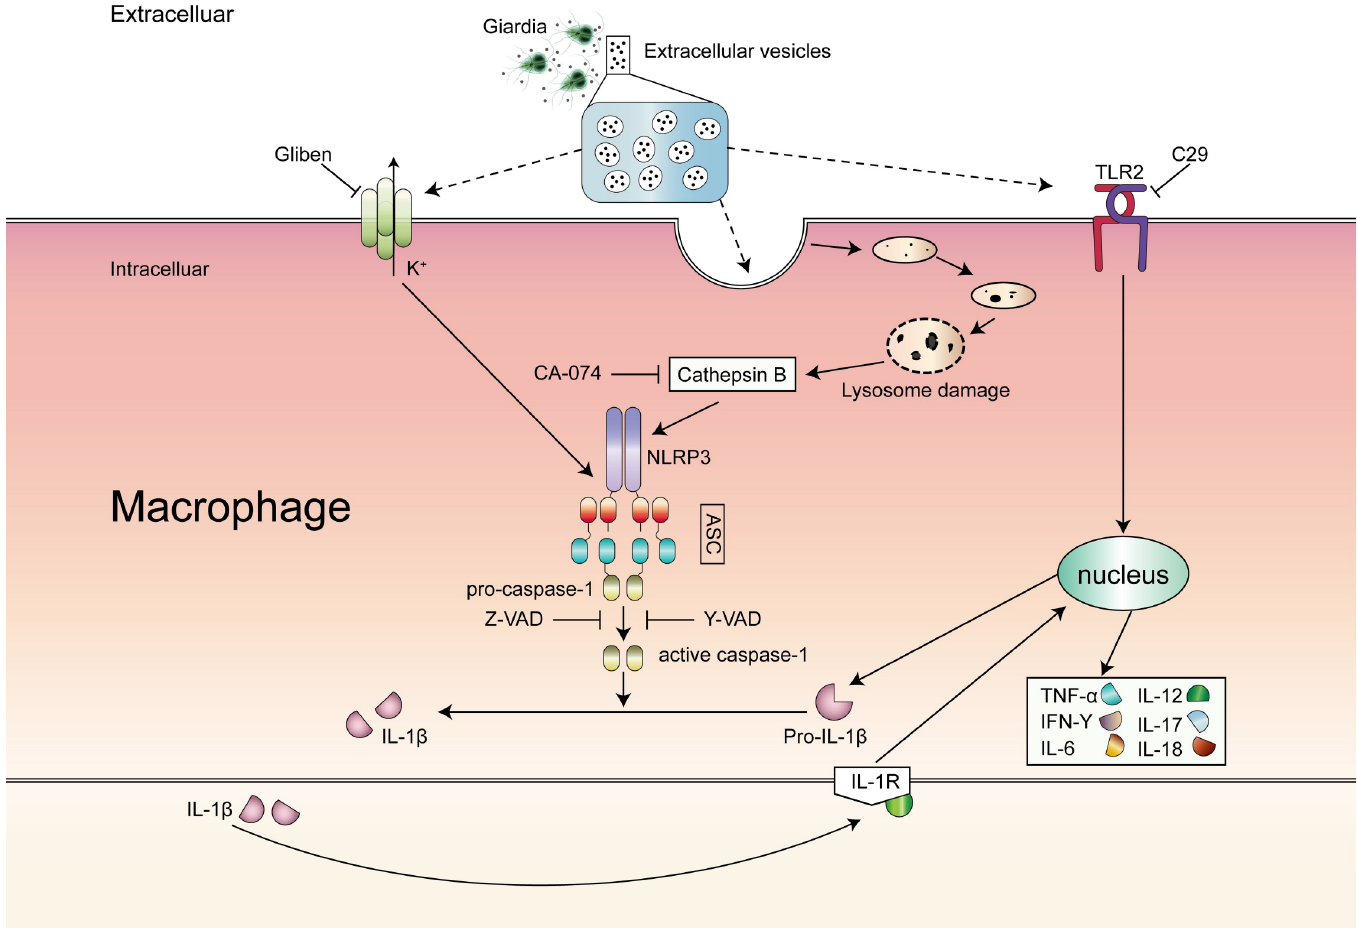
Fig 8. Schematic diagram of mechanisms underlying GEVs-induced inflammatory response. GEVs were secreted by G . duodenalis and entered into host cells triggering inflammatory response by recognizing extracellular TLR2 and intracellular NLRP3. NLRP3 inflammasome was activated, mediated IL-1 β release and controlled cytokines secretion. This process could be completely reversed by CA-074 methyl ester/zVAD-fmk or partial reversed by C29/Glibenclimide/Ac-YVAD-CHO.